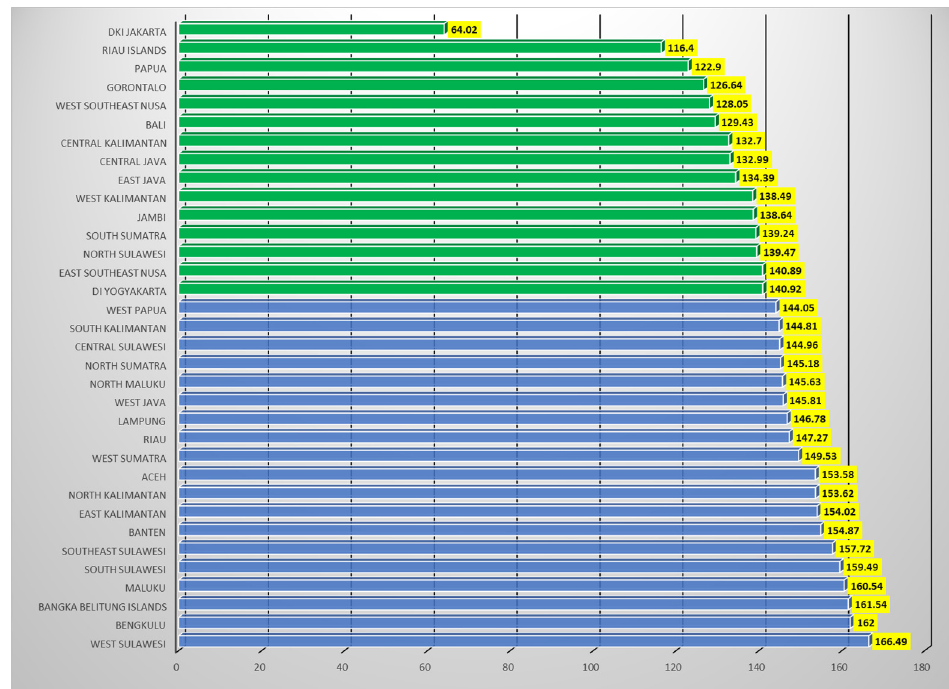
Figure 3. Mapping of the disaster risk index in Indonesia.